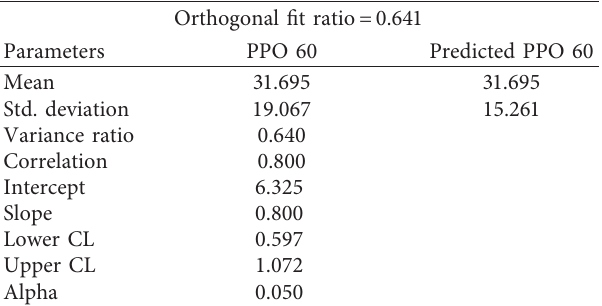
Table 2: Analysis details of the orthogonal regression.